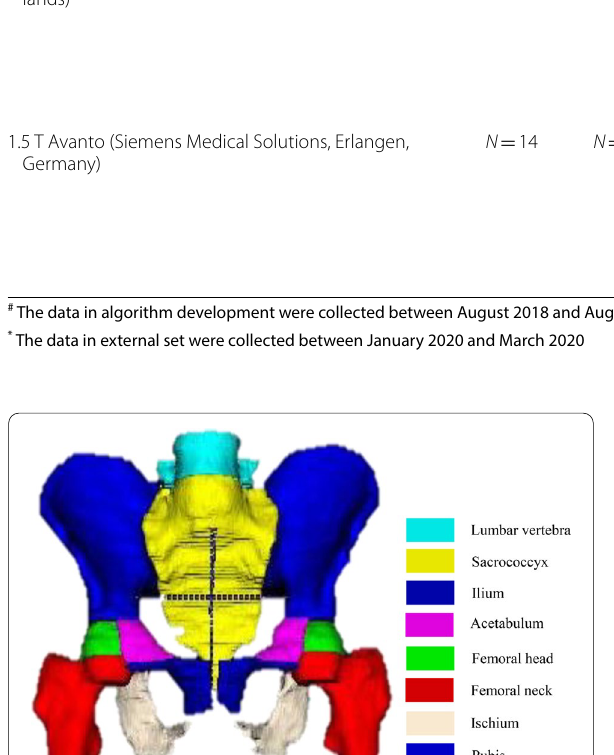
lumbar vertebra, = femoral head, =